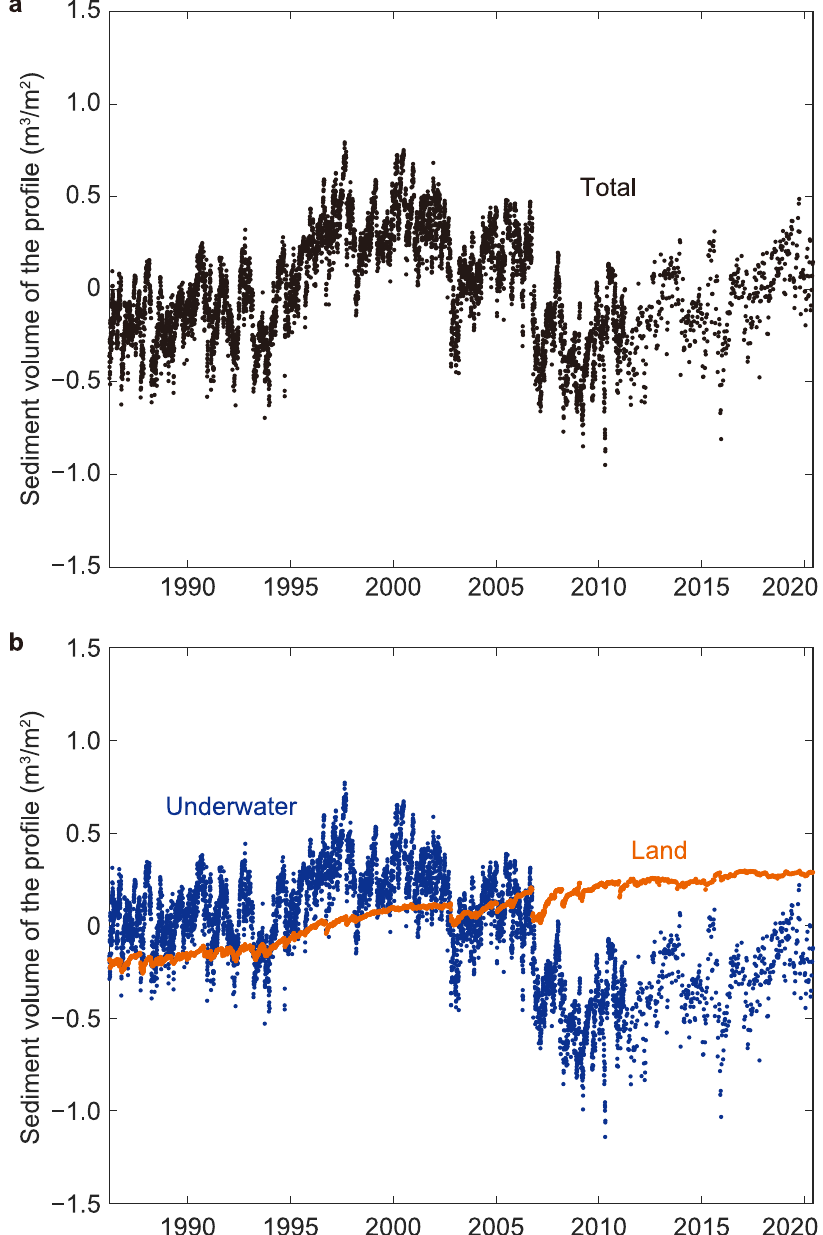
Figure 5. Time-series sediment volume. ( a ) Time series of total sediment volume; ( b ) time series of underwater sediment volume (blue) and of landward sediment volume (orange).